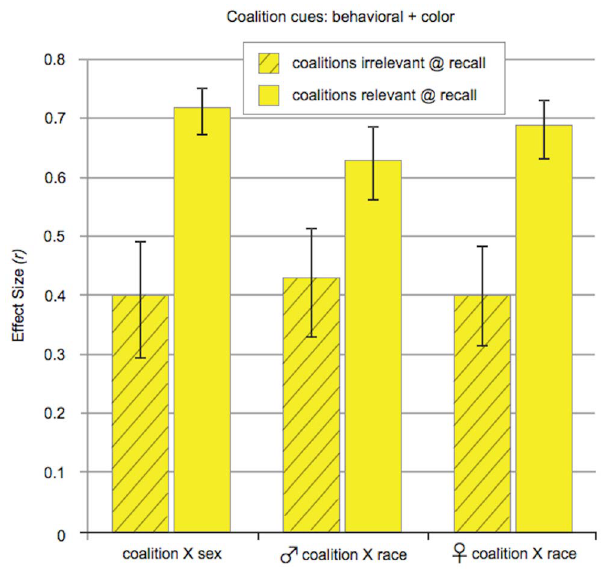
Figure 5. Effect sizes for categorization by coalition when membership is marked by visual and behavioral cues (Studies 5 and 6). Targets in these conditions wore different colored shirts, such that cues to coalition membership were both behavioral and visual. = , R denotes sex of target stimuli. Coalitional categorization was stronger than in the gray conditions (Studies 3 and 4), but followed the same pattern. Error bars: + / 2 1 S.E.